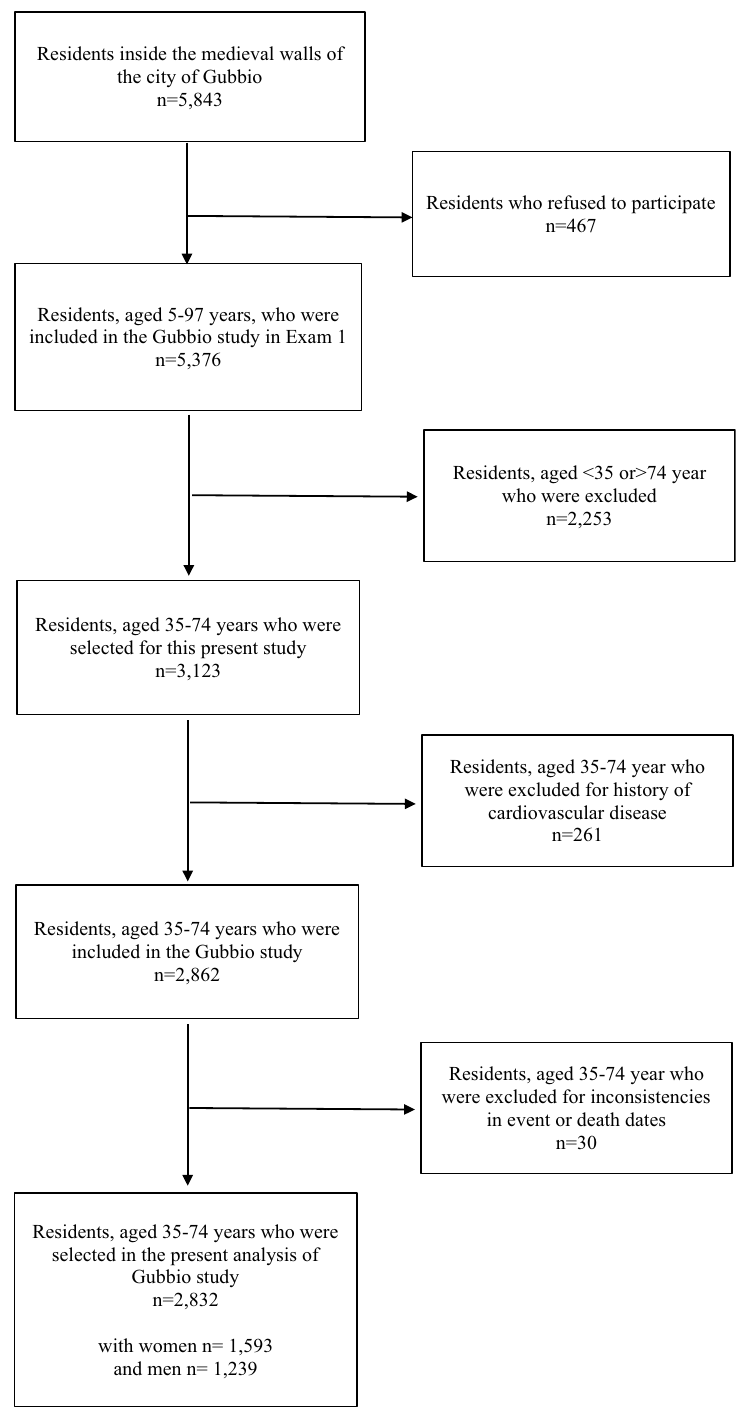
Figure 1. Flow chart of the present analysis of the Gubbio Population